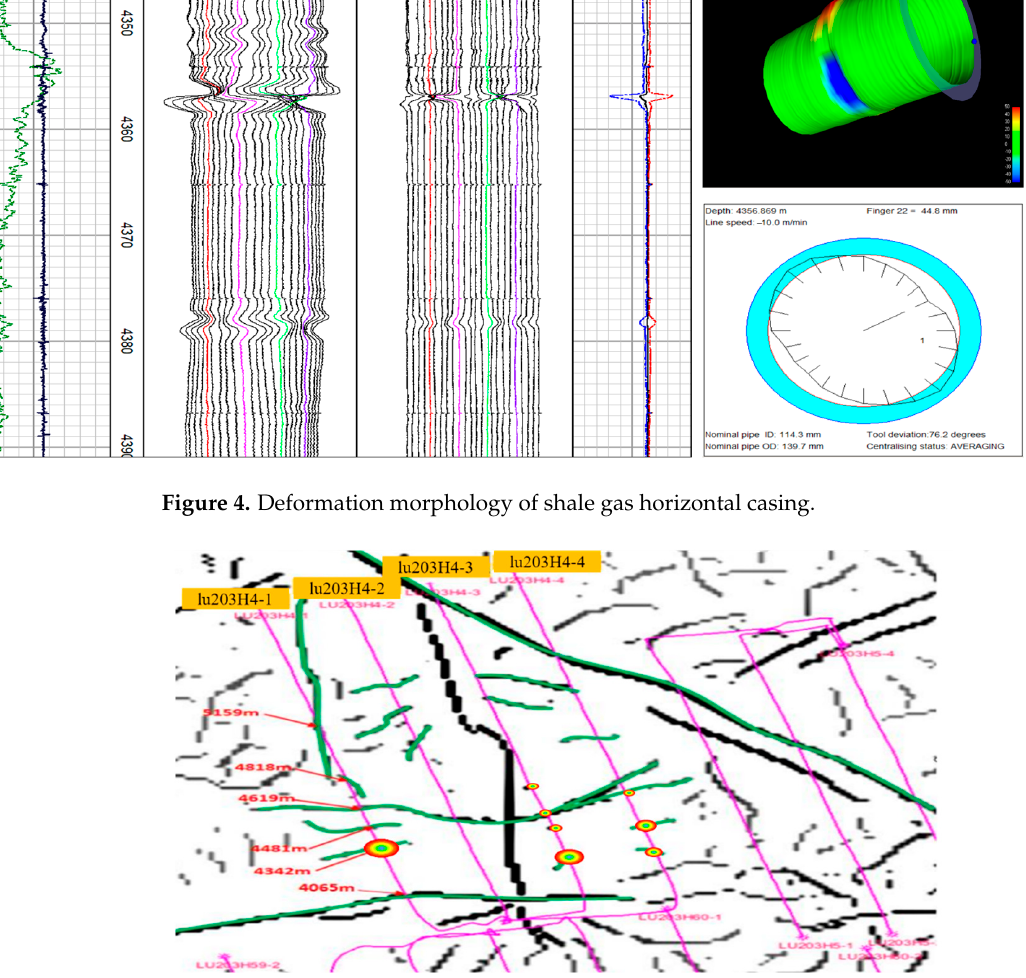
Figure 6. Verification results of production casing string. According to the statistics of casing deformation in Weiyuan Block, Sichuan, the pro- portion of deformation less than or equal to 30 mm is more than 80%, and the correspond- ing formation slip is less than or equal to 40 mm through laboratory tests and numerical